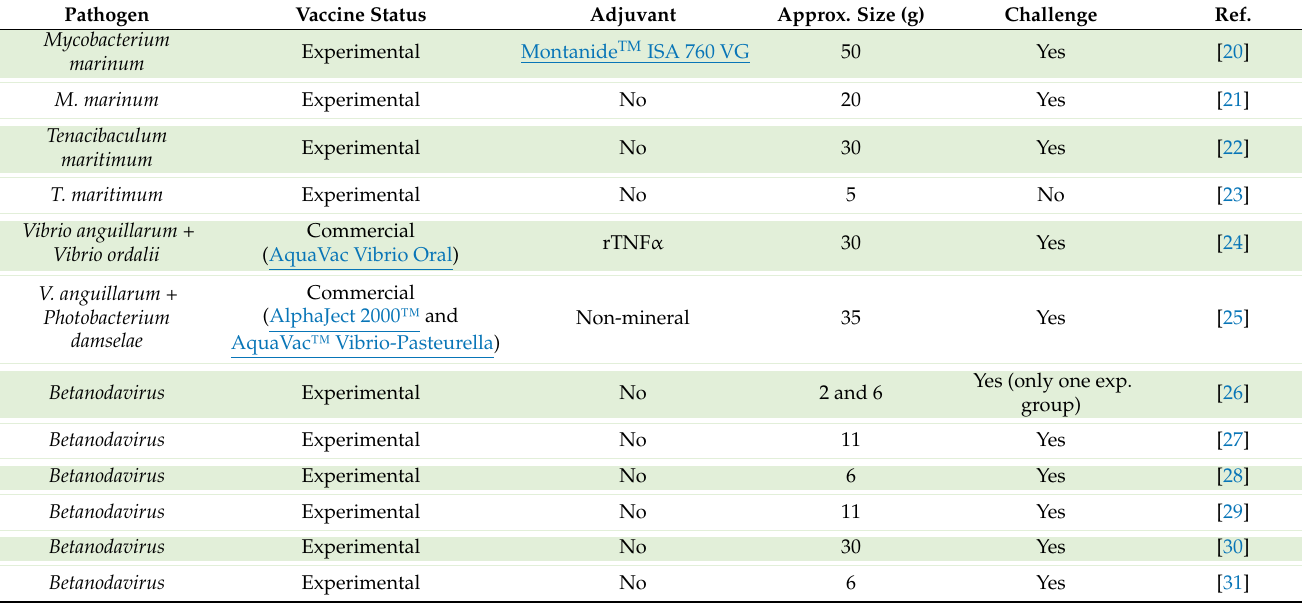
Table 1. Literature regarding experimental and commercial vaccines presented and discussed for European sea bass Dicentrarchus labrax . Approximate size refers to the fish body weight (BW) at the time of challenge or relative percentage of survival (RPS) calculation, as stated in or inferred from references. In case of commercial vaccines, the product description was linked. Challenges must be intended as homologous except when stated otherwise. List of abbreviations: ECPs—extracellular products; LPS—lipopolysaccharide; rTNF α —recombinant tumor necrosis factor alpha.